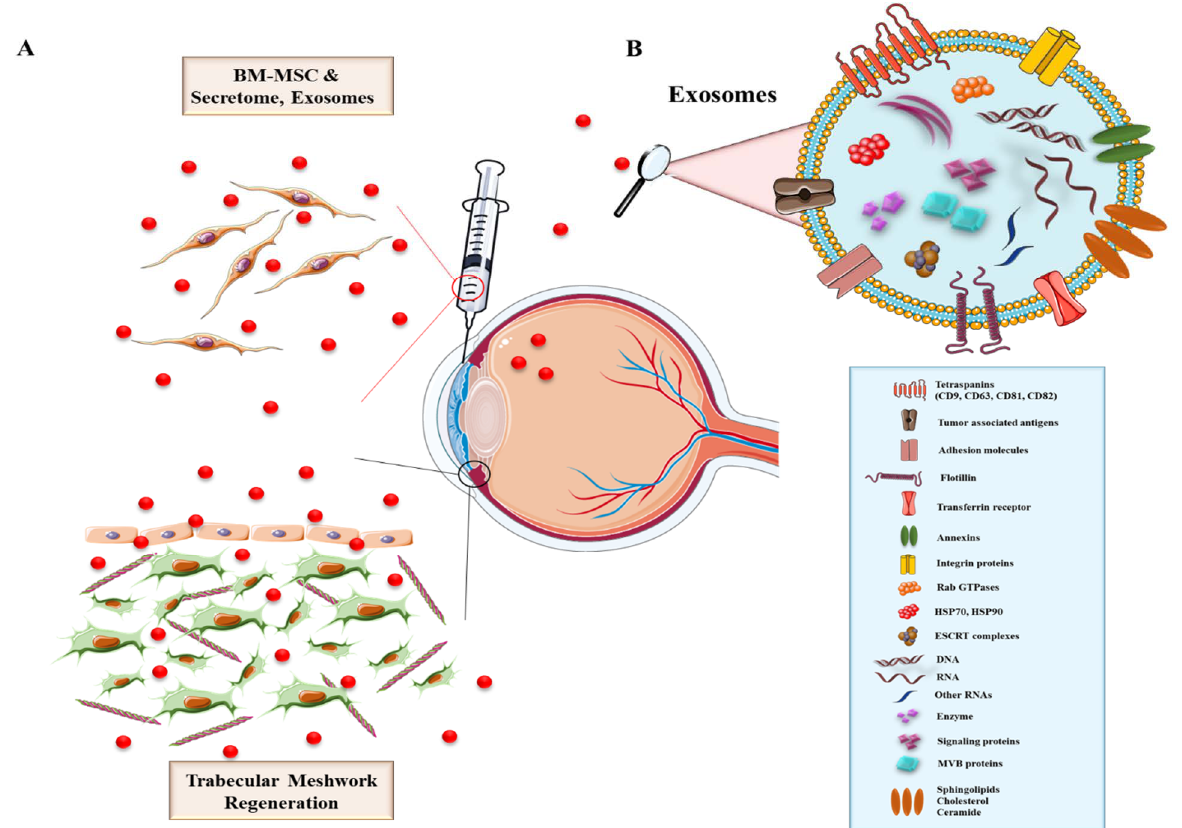
Figure 2. The uses of MSCs for ocular protection and regeneration. ( A ) MSCs-derived exosomes and neurotropic factors induce the regeneration of the trabecular meshwork. ( B ) The main components of exosomes, such as lipid bilayer (cholesterol, sphingolipids, ceramide), intracapsular proteins (MVB proteins, signaling proteins, HSP70, HSP90, Rab GTPases), various proteins (annexins, flotillin, tetraspanins, integrins), enzymes, nucleic acids (DNA, RNA, miRNAs), tumor associated antigens, ESCRT (endosomal sorting complex required for transport).